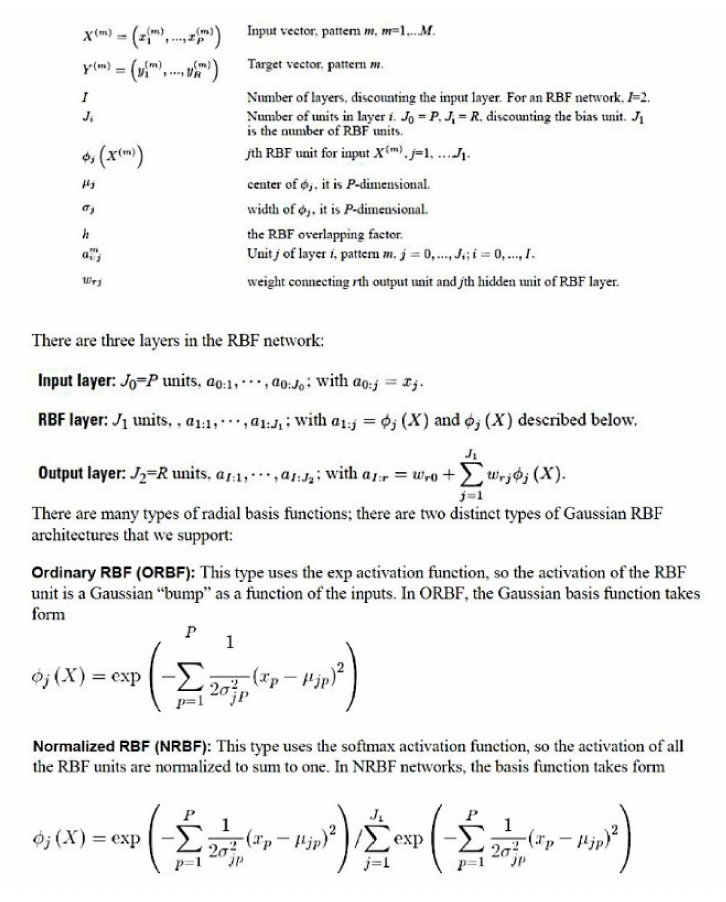
Figure 2. General architecture for radial basis function (RBF) networks. A radial basis function (RBF) network is a feed-forward, supervised learning network with only one hidden layer, called the radial basis function layer [32,33,60].